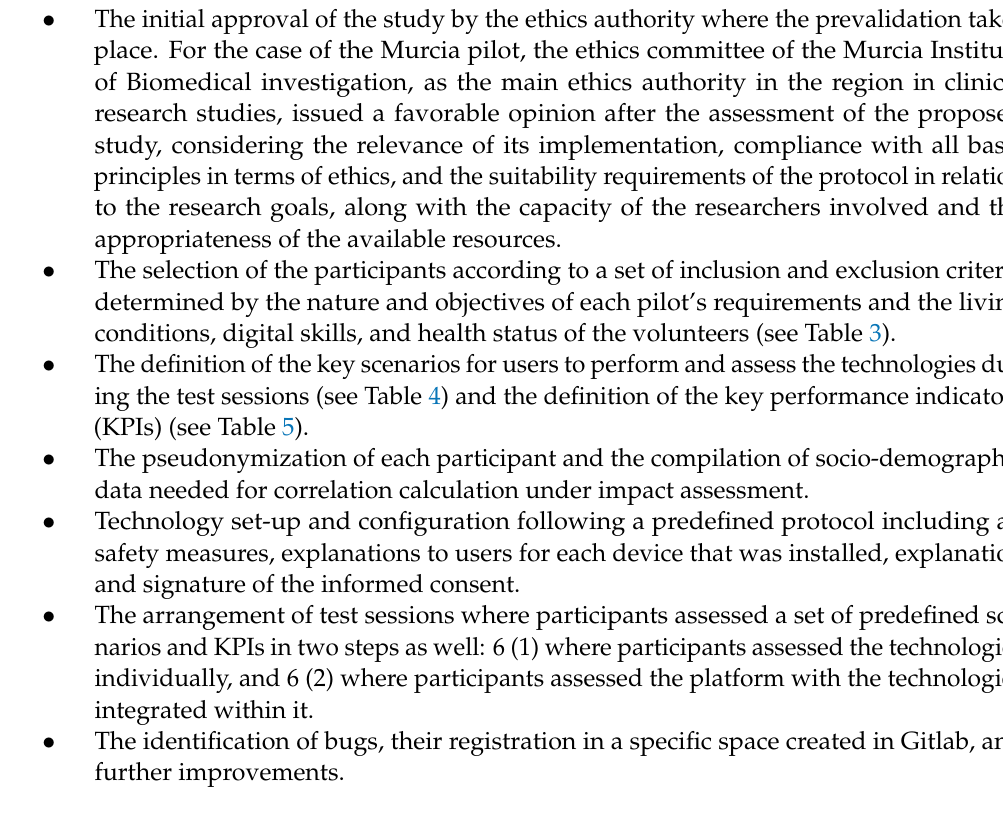
Table 3. Inclusion and exclusion criteria defined for users involved in the Pharaon Murcia